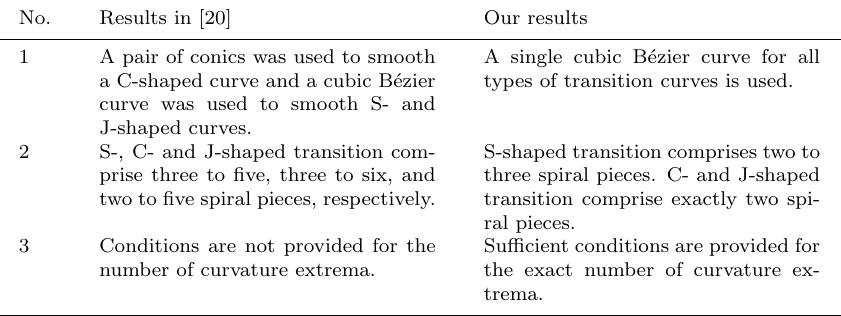
Table 1. Comparison of our results with the results in